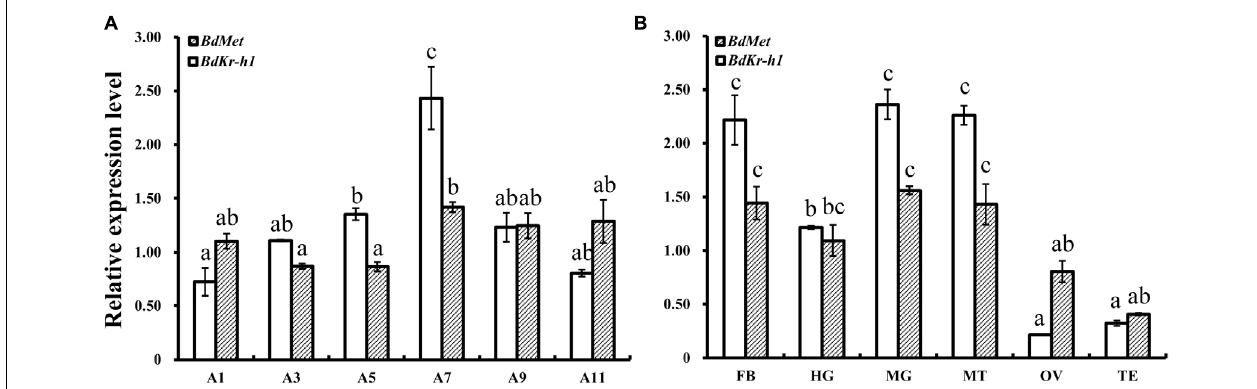
FIGURE 2 | Age- and tissue-specific spatiotemporal expression levels of BdMet and BdKr-h1 in adult B. dorsalis individuals. (A) Age-specific. A1, A3, A5, A7, A9, and A11 represent 1-, 3-, 5-, 7-, 9-, and 11-day-old adults. (B) Tissue-specific. FB, HG, MG, MT, OV, and TE refer to fat body, hindgut, midgut, Malpighian tubules, ovary, and testis of 7-day-old female adults, respectively. Three replicates were conducted, and the data were presented as mean ± SE. Bars with different letters above them differ significantly at P < 0.05.